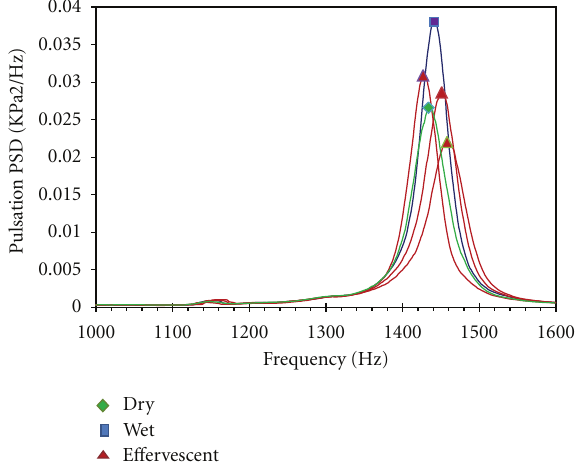
Figure 19: Trend of peak pulsation energy with water injection